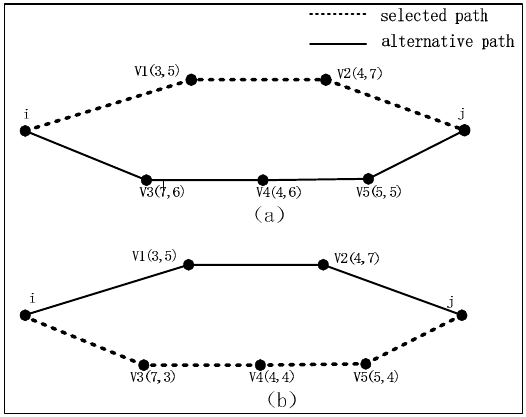
Figure 7. Delivery path selection of global dynamic routing in different load conditions. ( a ) Initial load of nodes; ( b ) changed load of nodes.